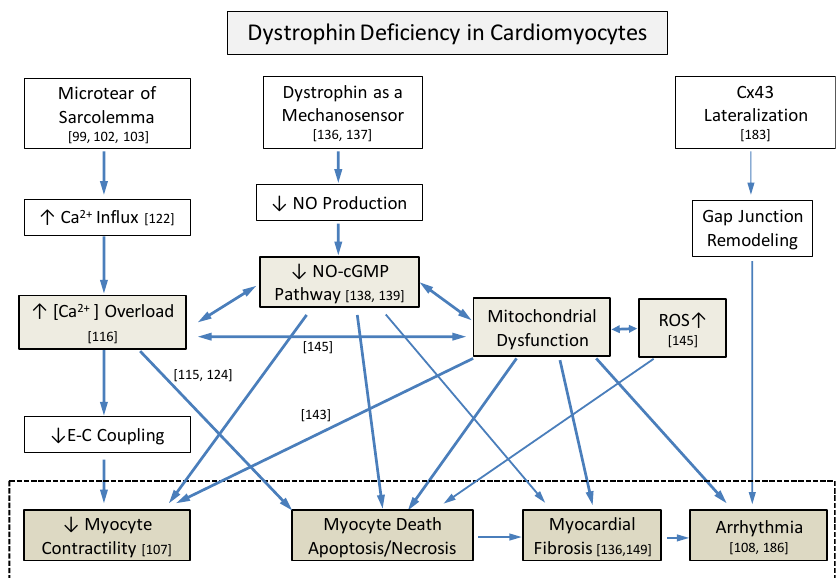
Figure 2. Complex underlying pathological interactions among primary structural vulnerability and secondary cellular responses that induce dystrophic hearts from dystrophin deficiency. Three major processes, including intracellular Ca 2+ overload, decreased NO-cGMP pathways, and mitochondrial dysfunction with increased reactive oxygen species (ROS), interact closely. Numbers indicate